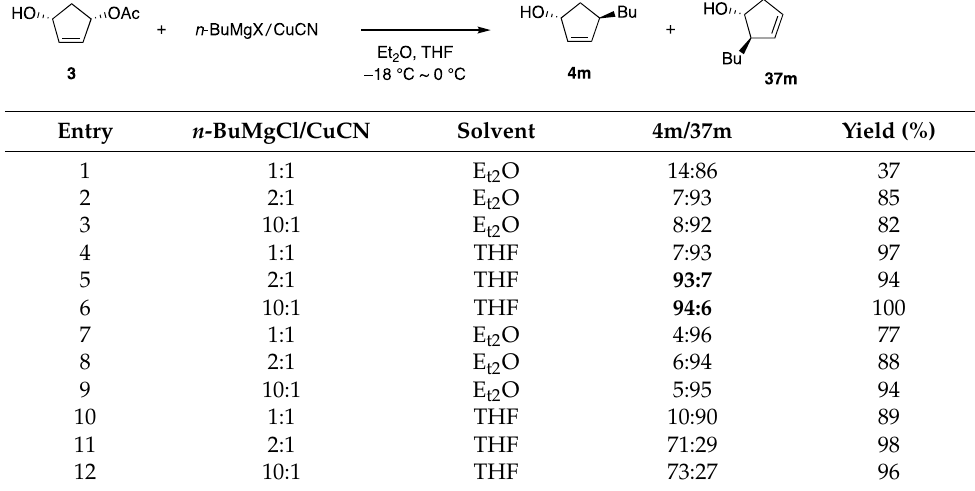
Table 6. Allylic substitution with n -BuMgX/CuCN.